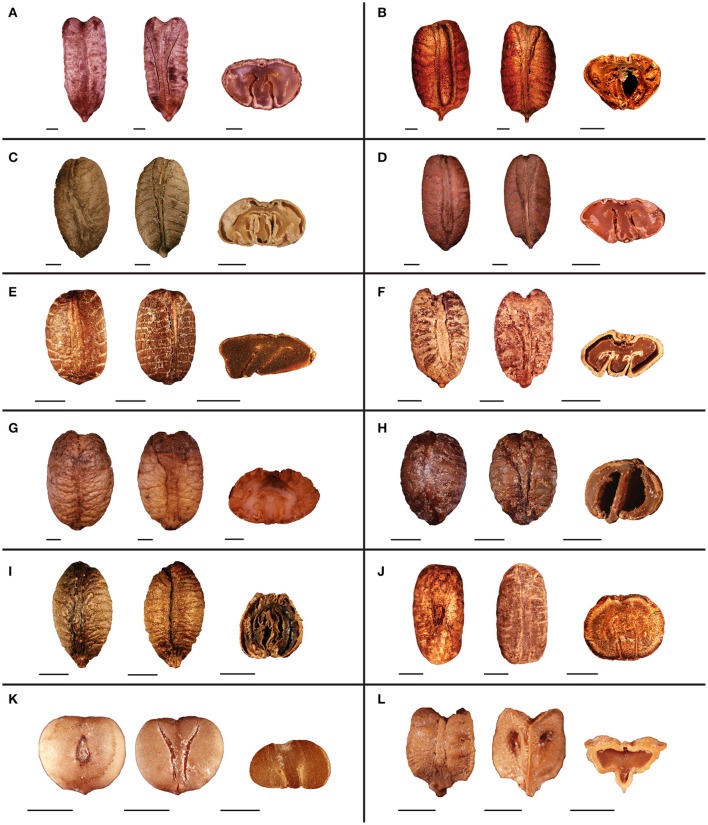
Seed morphology of representative species from clade VI of Tetrastigma. Dorsal, ventral and cross-sectional views are presented from left to right. (A)
T. jinghongense C.L. Li, (B)
T. cauliflorum Merr., (C)
T. sichouense C.L. Li, (D)
T. laoticum Gagnep., (E)
T. henryi Gagnep., (F)
T. pachyllylum (Hemsl.) Chun, (G)
T. obovatum Gagnep., (H)
T. retinervum Planch., (I)
T. petraeum Jackes, (J)
T. caudatum Merr. and Chun, (K)
T. hemsleyanum Diels and Gilg, (L)
T. formosanum (Hemsl.) Gagnep. Scale bars: (A–L) = 2 mm.